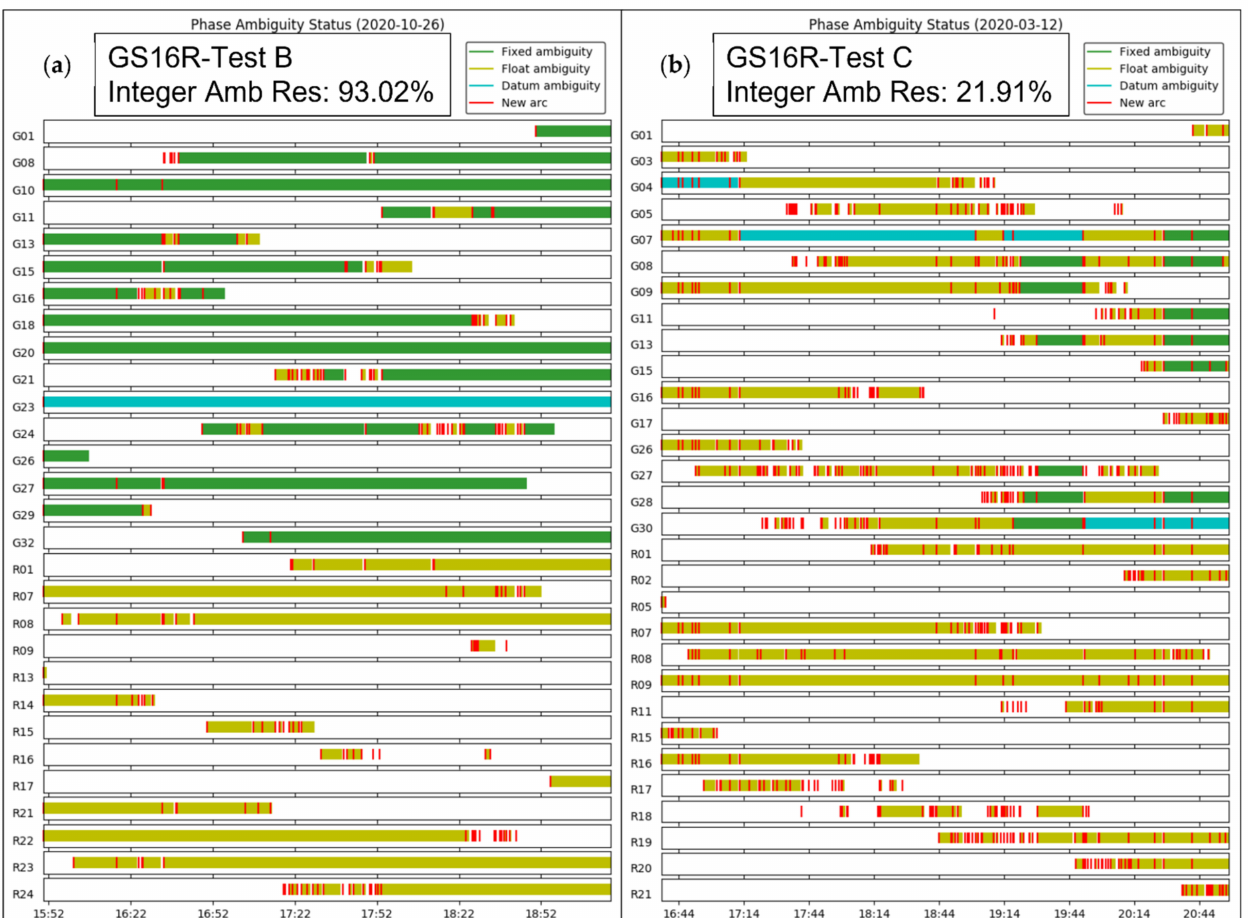
Figure 20. Ambiguity status plot from CSRS-PPP solution report from GS16R solutions for kinematic tests B outgoing only-( a ) and C ( b ). Time shown is